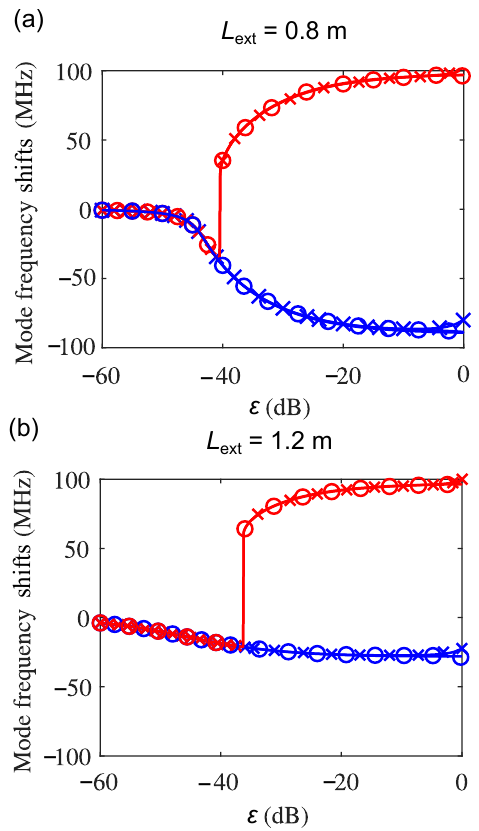
Figure 8. The mode split and shift in a THz QCL with optical feedback where ( a ) L ext = 0.8 m and ( b ) L ext = 1.2 m. In both figures, the fundamental (blue) and higher-order (red) solutions of the excess-phase equations when N = 1 (the solid lines), N = 2 (the solid line with cross markers), and N = 3 (the solid line with circle